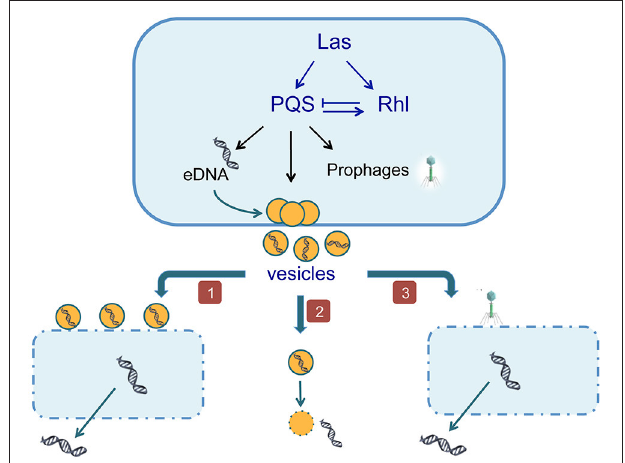
FIGURE 1 | The eDNA production in Pseudomonas aeruginosa is induced by QS signals. (1) Vesicles cause lysis of other cells of the same culture; (2) the secreted vesicles carry the eDNA across the membrane to the extracellular medium; (3) QS activates the induction of prophages causing the death of neighboring